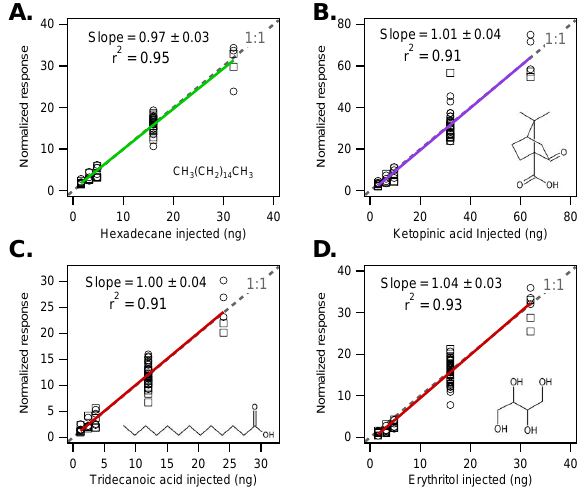
Figure 5. One month of multi-point calibrations of sample com- pounds during Study 1 (both cells shown as circles and squares). Response is corrected using a structurally similar deuterated inter- nal standard injected into every run, as is standard operating proce- dure to correct for run-to-run variability (line color represents the scenario of correction from Fig. 4). The average response of the in- strument to one loop of concentrated standard is used to normalize all data to demonstrate 1 : 1 linearity.